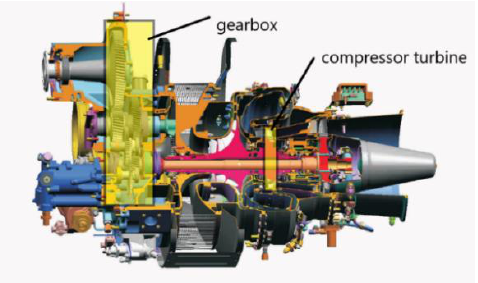
Figure 1. Cross-section of the AI-450 engine [16]. (Reproduced with permission from Ivchenko-